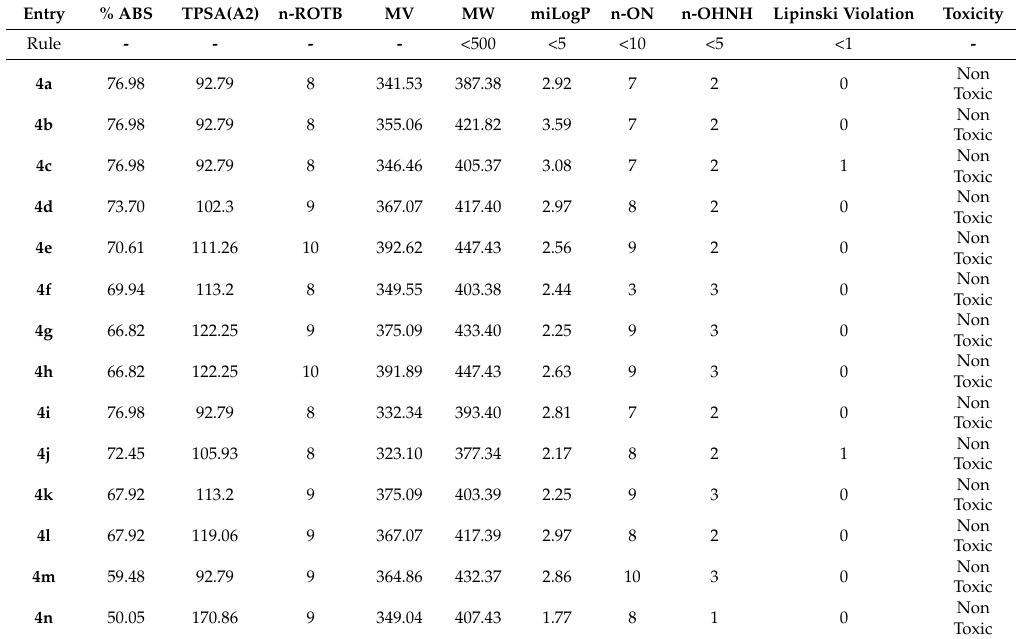
Table 5. Pharmacokinetic parameters of the synthesized compounds 4 ( a – n ) for good oral